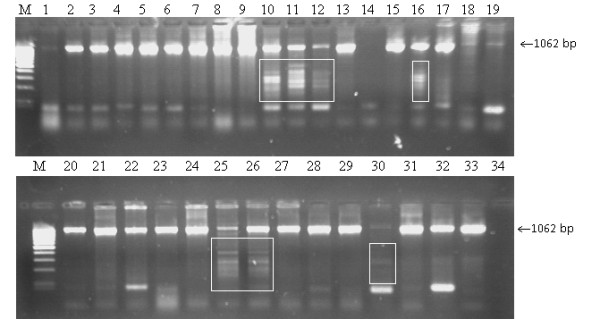
PCR results for the detection of the meq oncogene in Marek's disease virus. M-Mass Ruller 100 kb Plus (80 bp-10 000 bp), Fermentas, 1 - 23_07_PL, 2 - 25_07_PL, 3 - 29_07_PL, 4 - 30_07_PL, 5 - 31_07_PL, 6 - 32_07_PL, 7 - 2_08_PL, 8 - 3_08_PL, 9 - 7_08_PL, 10 - 8_08_PL, 11 - 45_08_PL, 12 - 48_08_PL, 13 - 56_08_PL, 14 - 73_08_PL, 15 - 8_09_PL, 16 - 23_09_PL, 17 - 26_09_PL, 18 - 40_09_PL, 19 - 42_09_PL, 20 - 45_09_PL, 21 - 51_09_PL, 22 - 81_09_PL, 23 - 82_09_PL, 24 - 86_09_PL, 25 - 8_10_PL, 26 - 10_10_PL, 27 - 11_10_PL, 28 - 30_10_PL, 29 - 61_10_PL, 30 - BAC_31_07Δmeq, 31 - BAC_7_08, 32 - HPRS16, 33 - Rispens, 34 - negative DNA control extracted from non-infected chicken embryo kidney cells. Smeared products are marked with a white box.